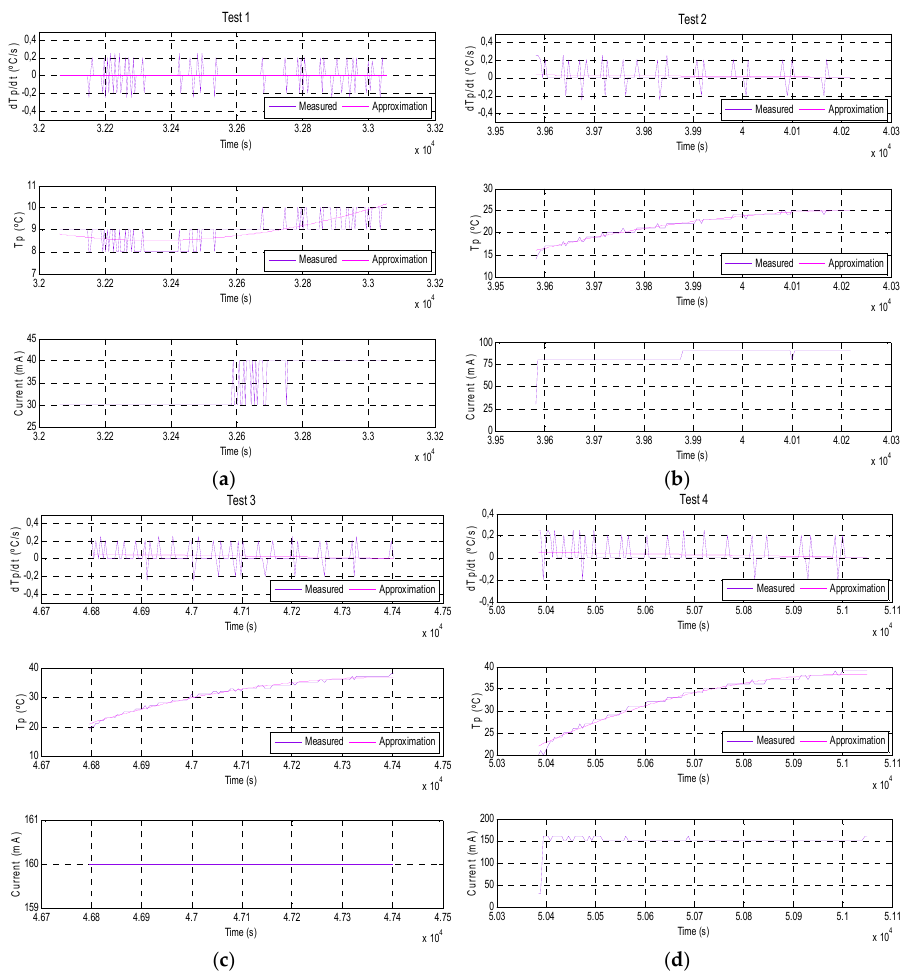
Figure 4. System response for quasi-stationary tests performed on 2 February 2010 for various time zones with respect to GMT: ( a ) 8 GMT; ( b ) 10 GMT; ( c ) 12 GMT; and ( d ) 13 GMT.